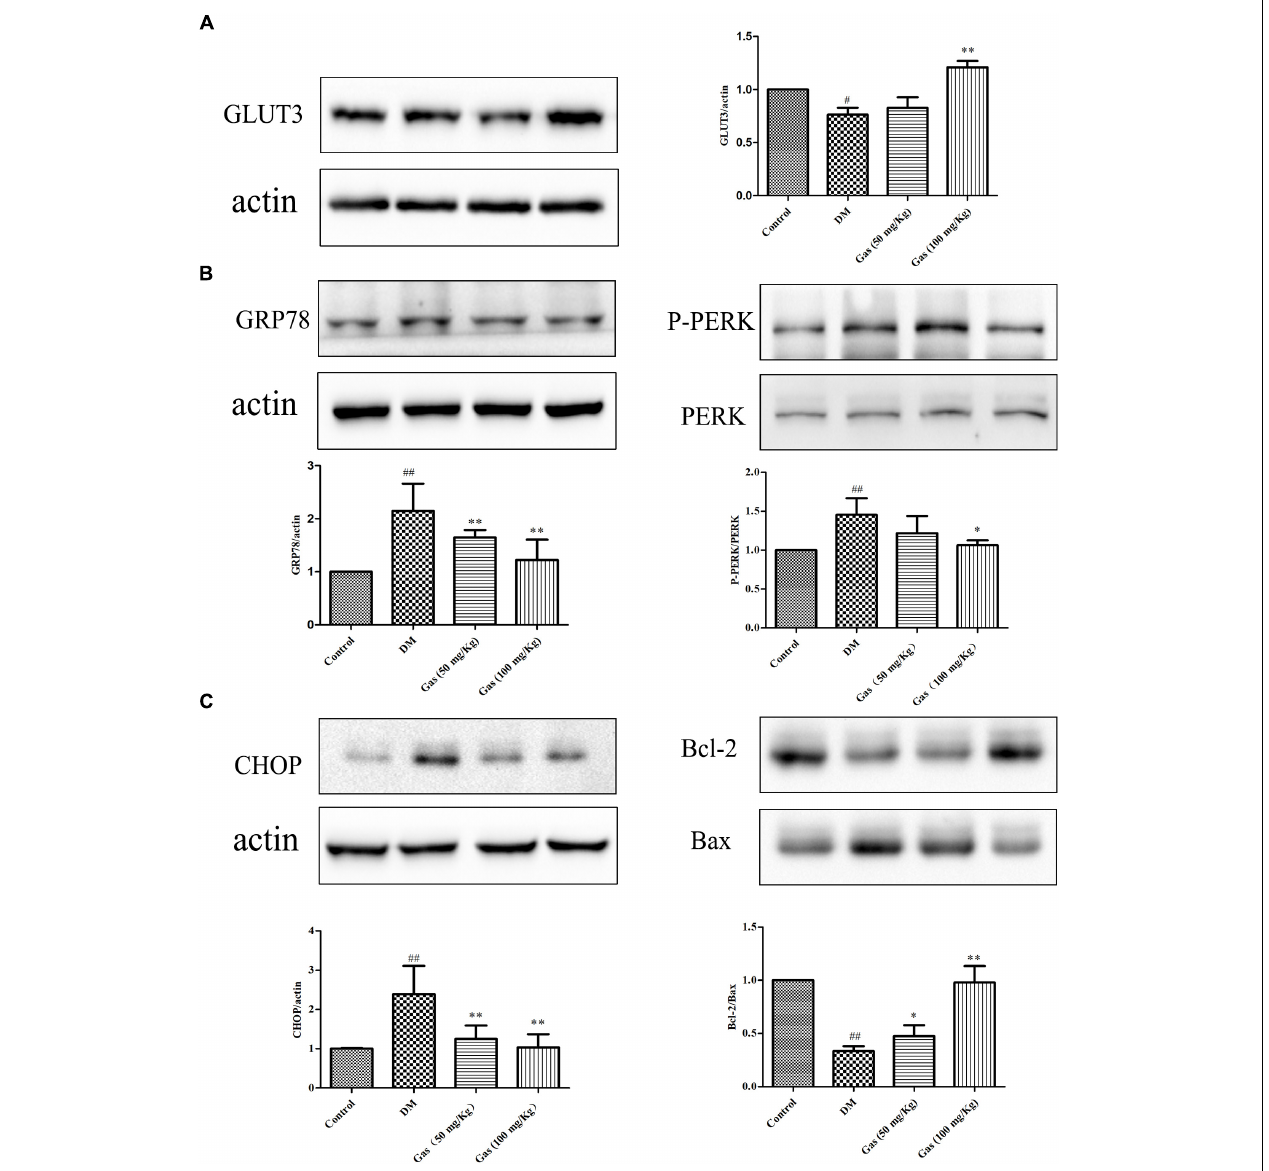
FIGURE 8 | Gas increases GLUT3 expression and inhibits ERS pathway in the hippocampus of DM rats. (A) Representative protein bands and Western blot analysis of GLUT3 in the hippocampus of each group. (B) Representative protein bands and Western blot analysis of GRP78, P-PERK, PERK, CHOP, Bax and Bcl-2 in the hippocampus of each group. (C) Representative protein bands and Western blot analysis of CHOP, Bax and Bcl-2 in the hippocampus of each group. Values are represented as means ± SD for three rats in each group. # P < 0.05, ## P < 0.01, compared with the control group. ∗ P < 0.05, ∗∗ P < 0.01, compared with the DM